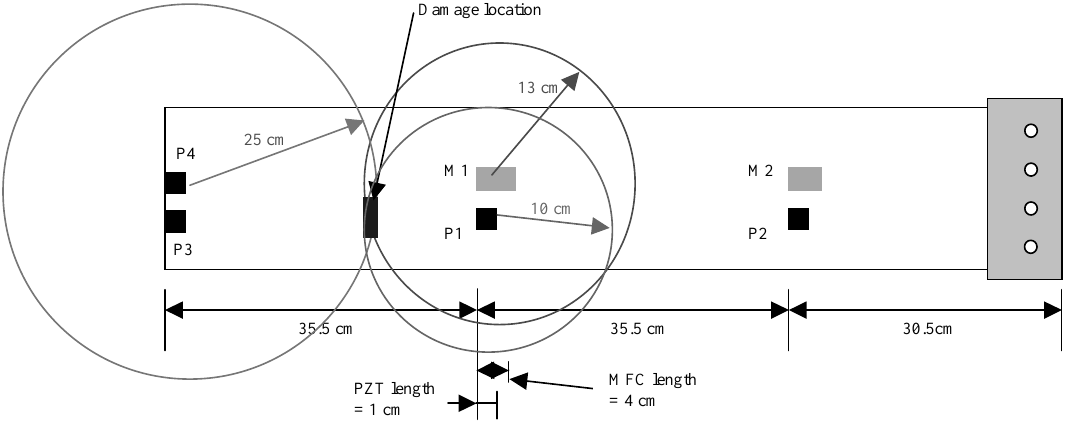
Fig. 13. Damage Location Process for Damage